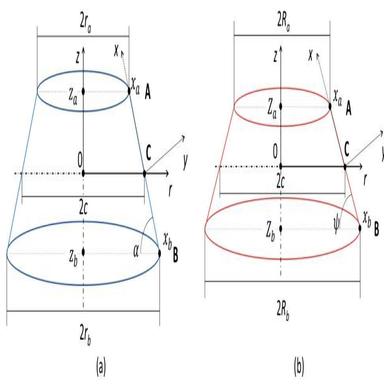
Middle-surface representation of an (a) unloaded, (b) loaded truncated conical shell.